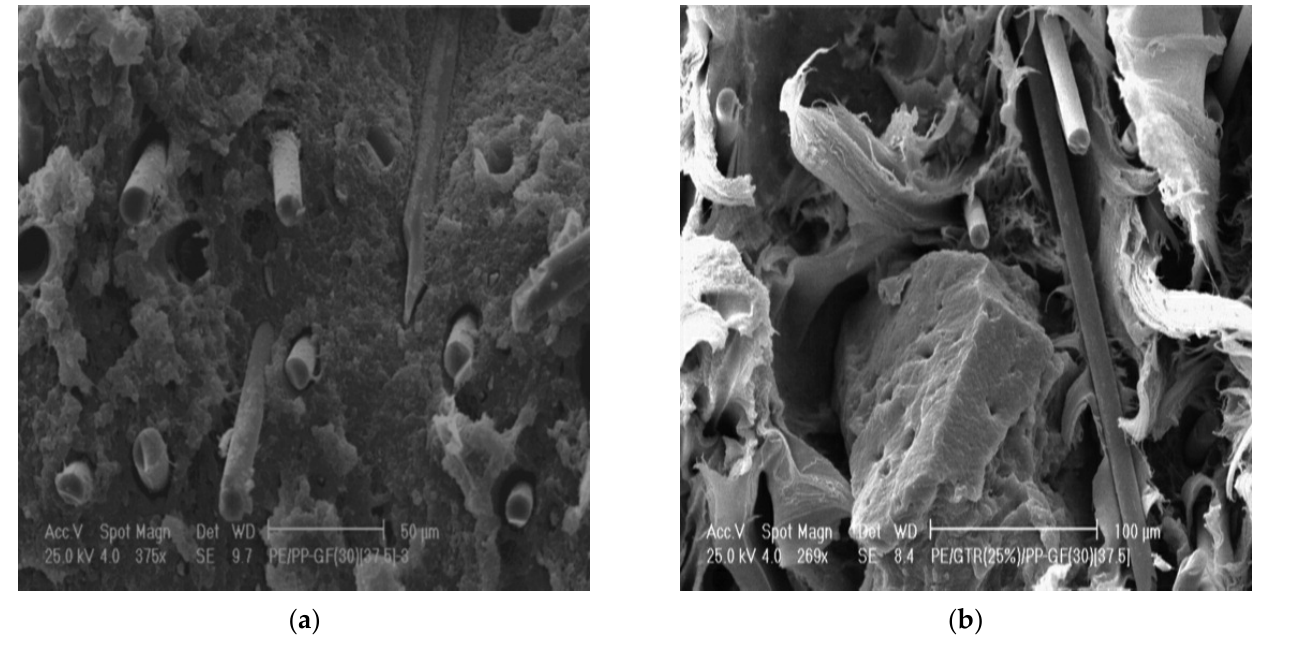
Figure 10. ( a ) SEM micrograph of the fracture surface of HDPE filled with 37.5 wt% PP–GF; ( b ) [PE(2)/GTR(25)]/[PP–GF(30)](37.5) [31].